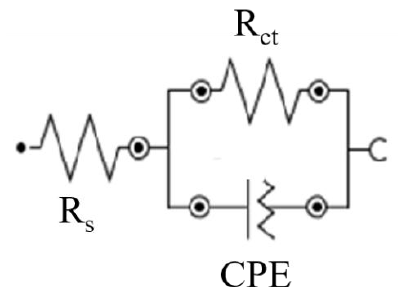
Figure 8. The equivalent circuit of corrosion tests.